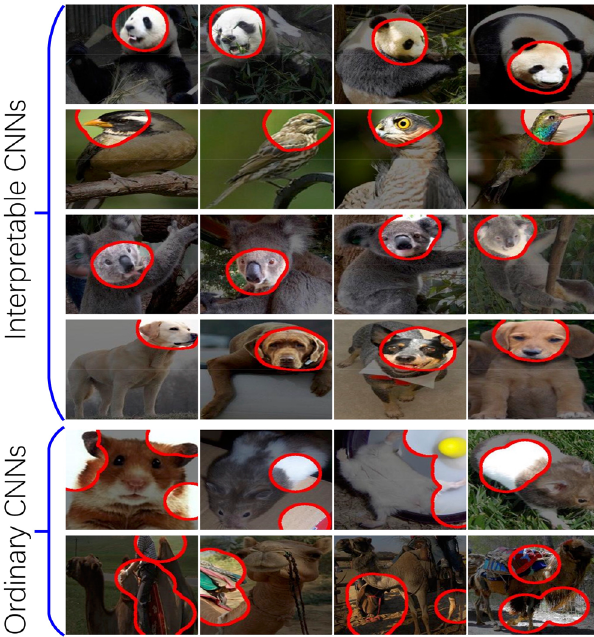
Fig. 15 Illustration of the interpretable CNN designed by Zhang et al. 118 . The top four rows show example fi ler feature maps from the interpretable CNN and the bottom two rows show example fi lter feature maps from an ordinary CNN. Note that feature maps from the interpretable CNN fi lters tend to be meaningful (animal heads in this example) while feature maps from ordinary CNN fi lters are usually meaningless. These fi lter feature maps are computed from fi lter receptive fi elds following a technique proposed by Zhou et al. 161 . Figure reprinted from ref. 118 with permission. Copyright 2018